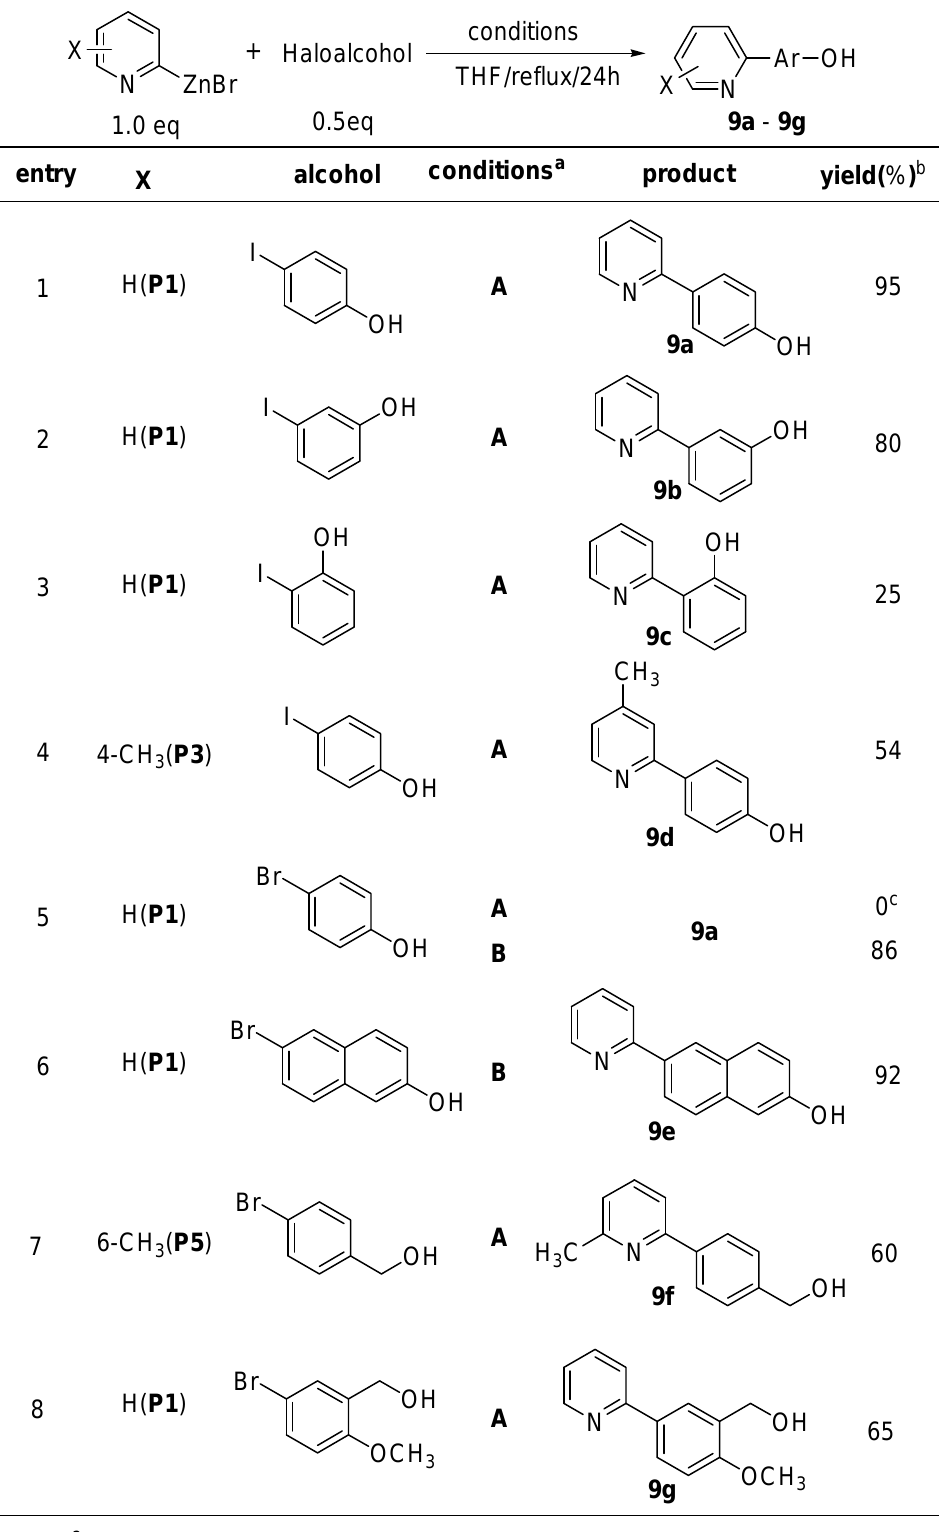
Table 9. Coupling reactions with haloaromatic